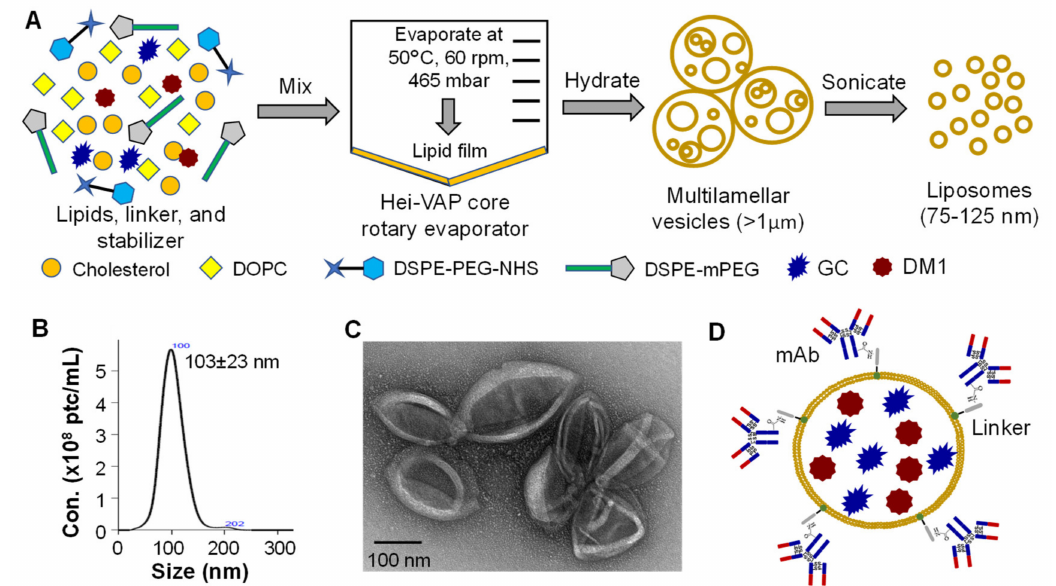
Figure 1. Liposome synthesis and characterization. ( A ) Liposome synthesis schematic diagram. The mixture of cholesterol, DOPC, DSPE-PEG-NHS and DSPE-mPEG was evaporated at 60 ◦ C and 465 mbar for 2 h, followed by hydration to form multilamellar particles with diameter of >1 µ m and sonication to generate homogeneous liposomes. ( B ) NanoSight showing homogenous distribution of liposomes with diameter of 103 ± 23 nM. ( C ) The transmission electron microscopes (TEM) image indicating the high purity and morphology of synthesized liposomes. ( D ) TNBC-targeting mAb was tagged to the surface of liposomes via the integrated DSPE-PEG-NHS linker and combined chemotherapies (i.e., GC and DM1) were packed into the